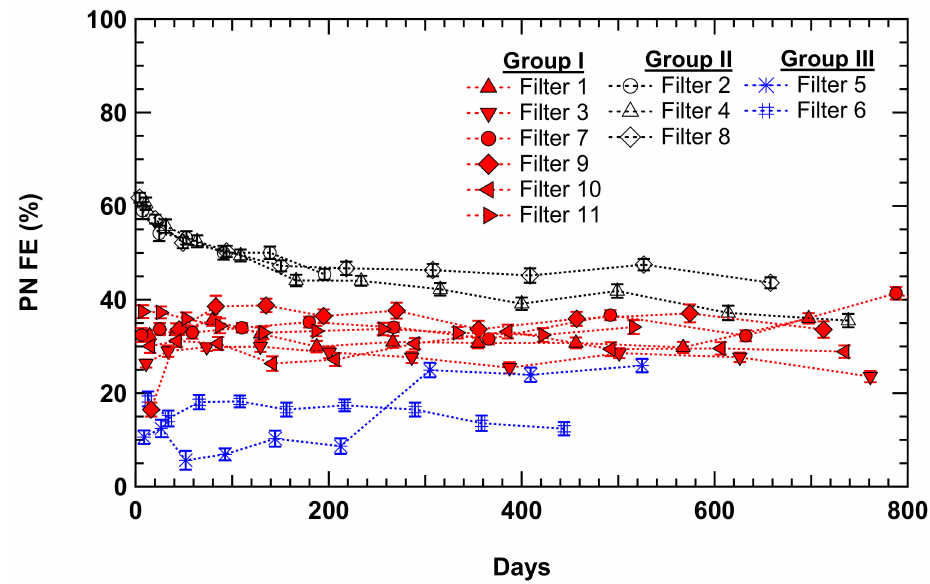
Figure 8. Particle number filtration efficiency over time for Group I (electrostatic filters), Group II (normal filters), and Group III (underperforming